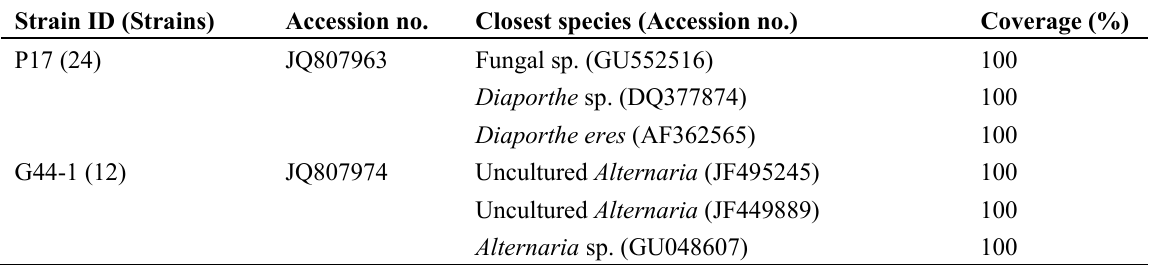
Table 1. Similarity between the isolates and closest species in